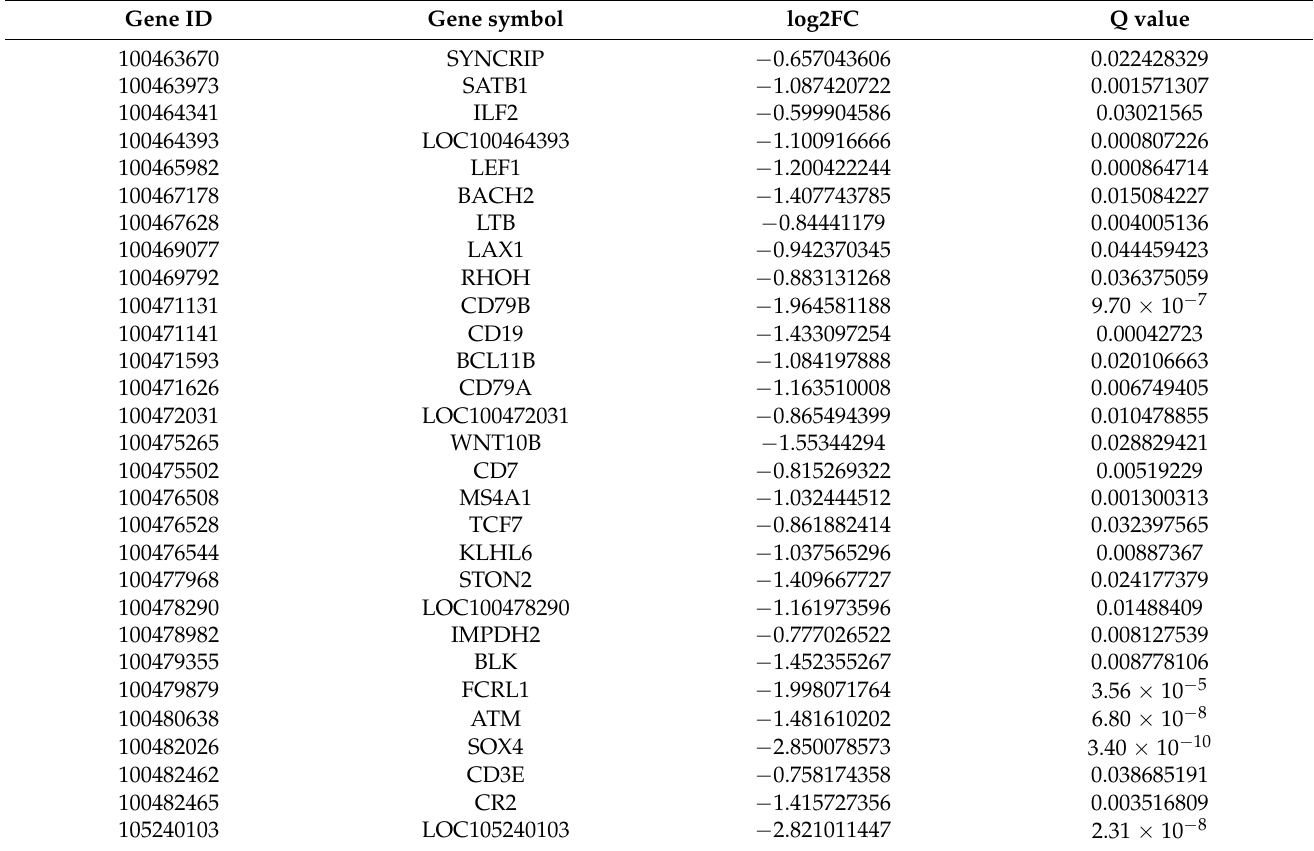
Table 3. Downregulated immune genes in older